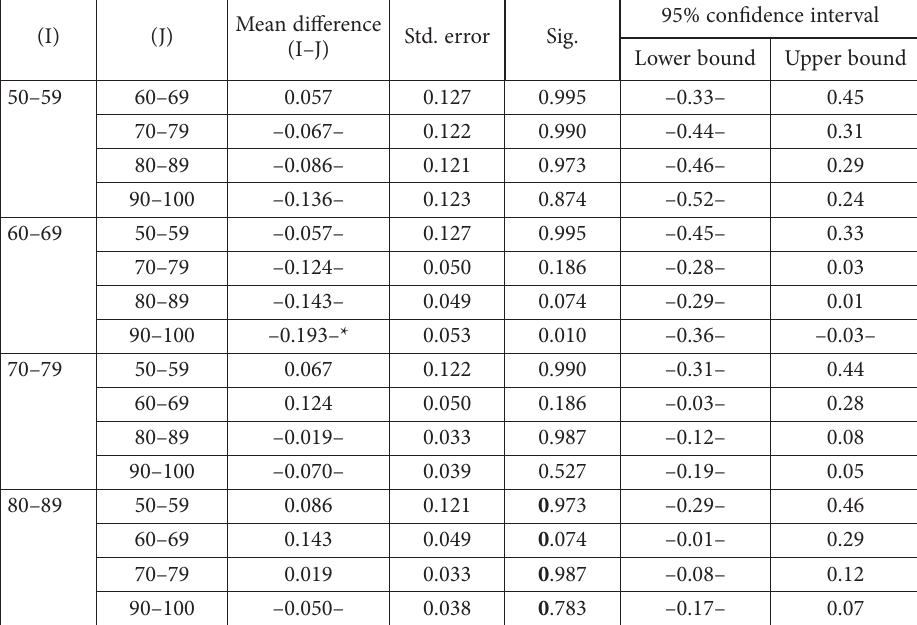
Table 7. Scheffé method to find the differences of academic achievement (source: created by